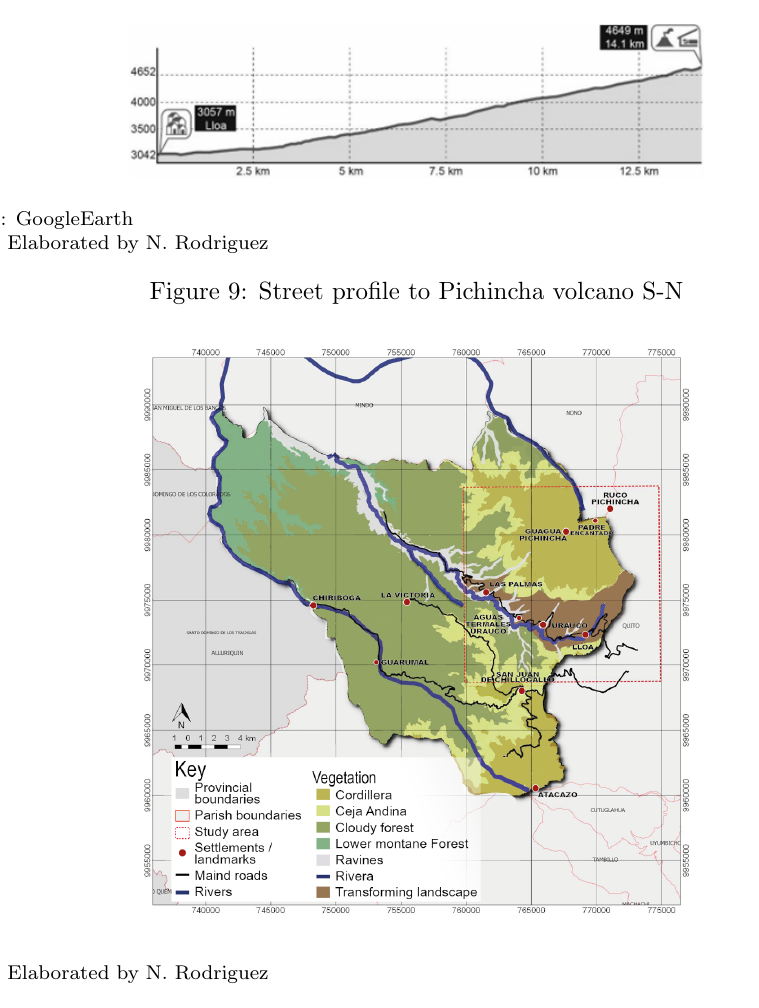
Figure 10: The Lloa landscape unit and the smaller area with the richest landscape as it is the transition between the mountains and the coast, with the particularity of humidity and low